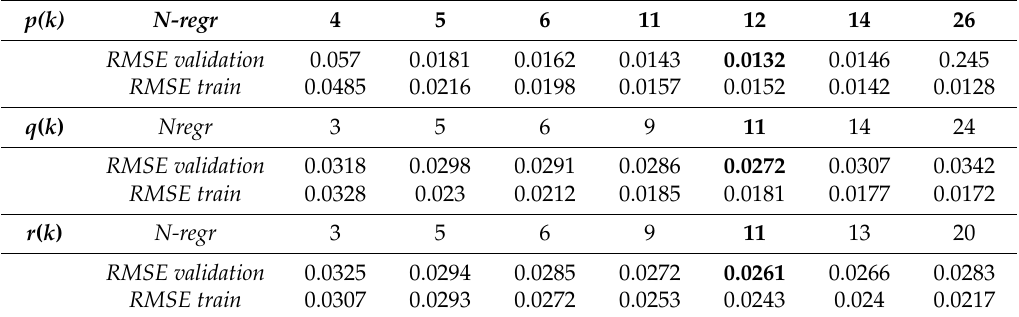
Table 1. RMSE index evaluated with the validation and trading flight data and the corresponding number of regressors ( N regr ) selected by the stepwise algorithm for different p